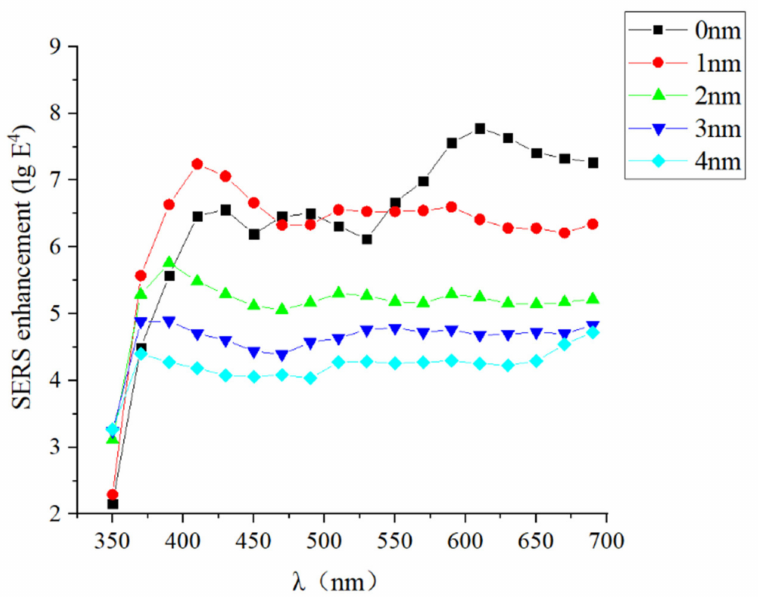
Figure 8. Order of E 4 at different gap and wavelength. Total enhancement factor of SERS is propor- tional to E 4 , when the gap is 0 nm and wavelength is 630 nm, total enhancement factor increased by about 8 orders of